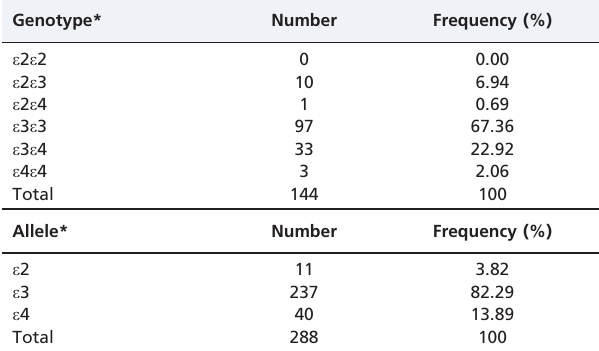
Table 1 - Genotypic and allelic distribution of APOE in the analyzed population of the Parque Universita´rio community in Fortaleza, Ceara´,